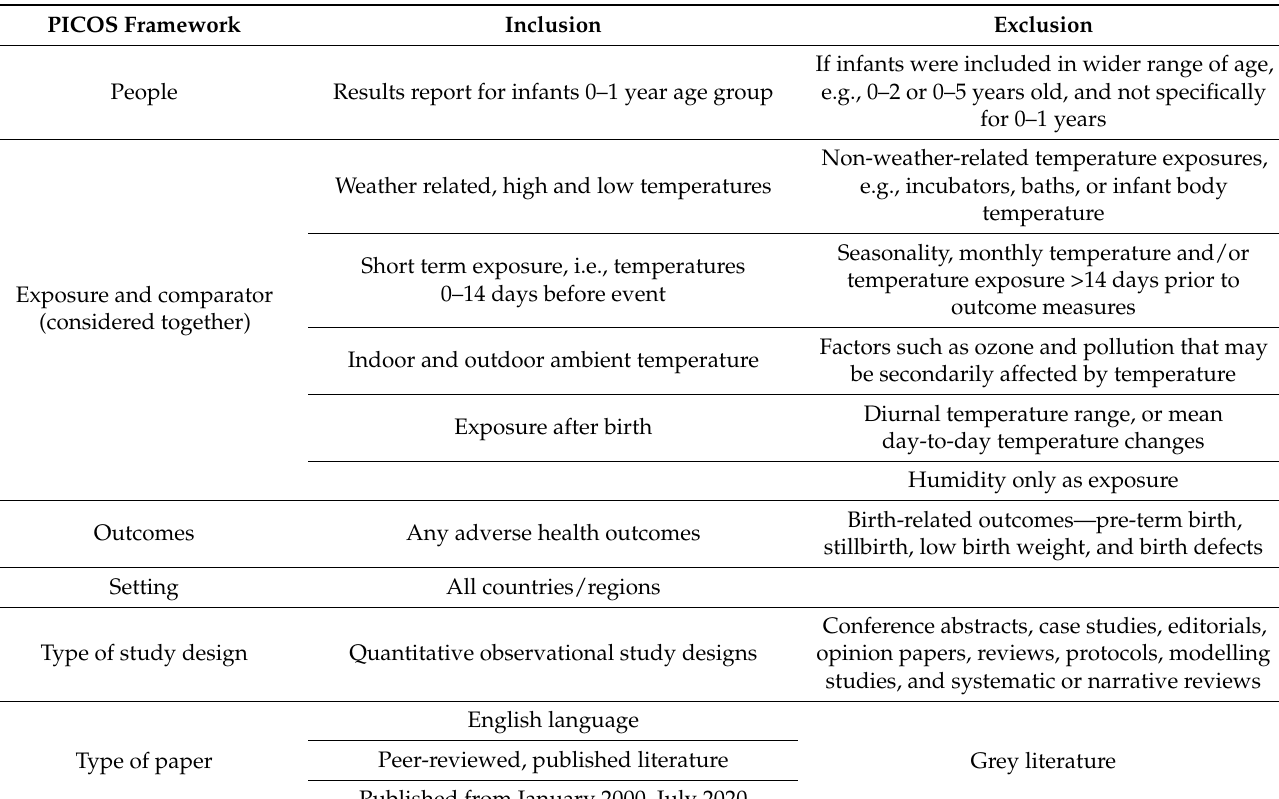
Table 1. Inclusion and exclusion criteria using the PECOS